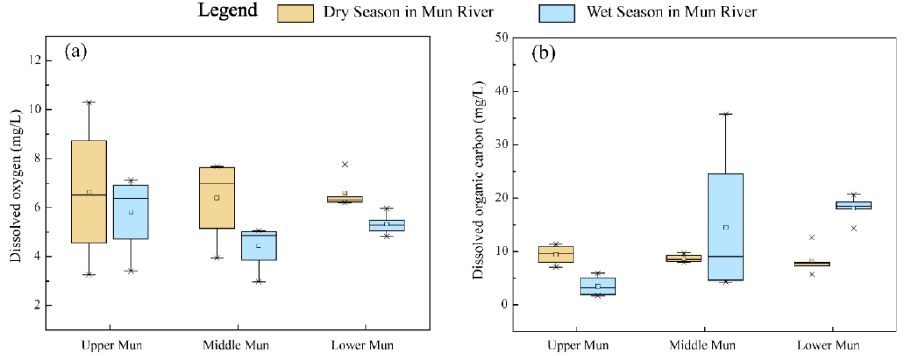
Figure 2. ( a ) Dissolved oxygen (DO) and ( b ) Dissolved organic carbon (DOC) in the upstream, midstream and downstream of Mun River (MR) during dry and wet season; data are from [29,45] .